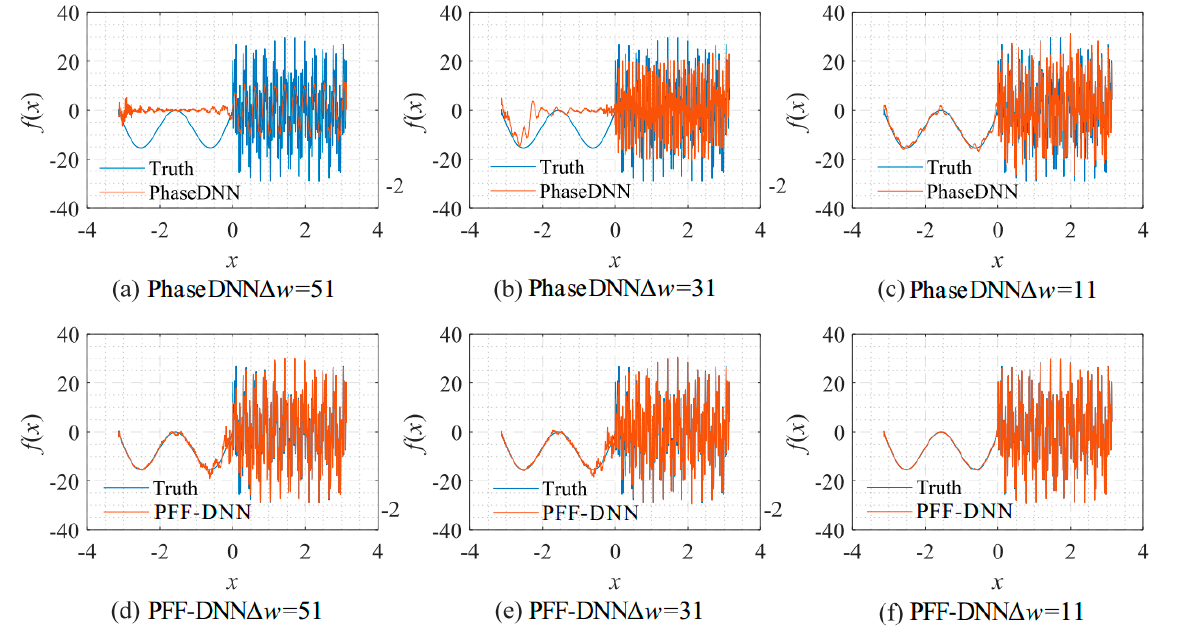
Figure 20. The influence of Δ ω on the algorithm performance. The fitting results of the PhaseDNN method after 10,000 updates: ( a ) Δ ω = 51; ( b ) Δ ω = 31; and ( c ) Δ ω = 11. The fitting results of the PFF-DNN method after 10,000 updates: ( d ) ∆ ω = 51; ( e ) ∆ ω = 31; and ( f ) ∆ ω = 11.